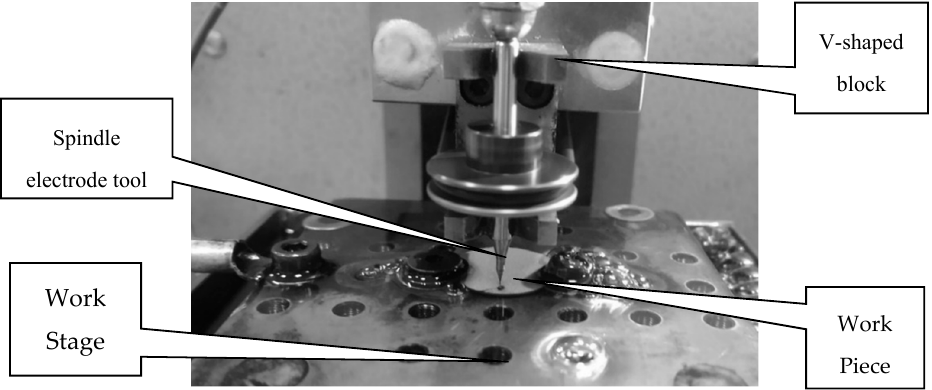
Figure 3. Structure of the spindle tools on the V-shaped block.